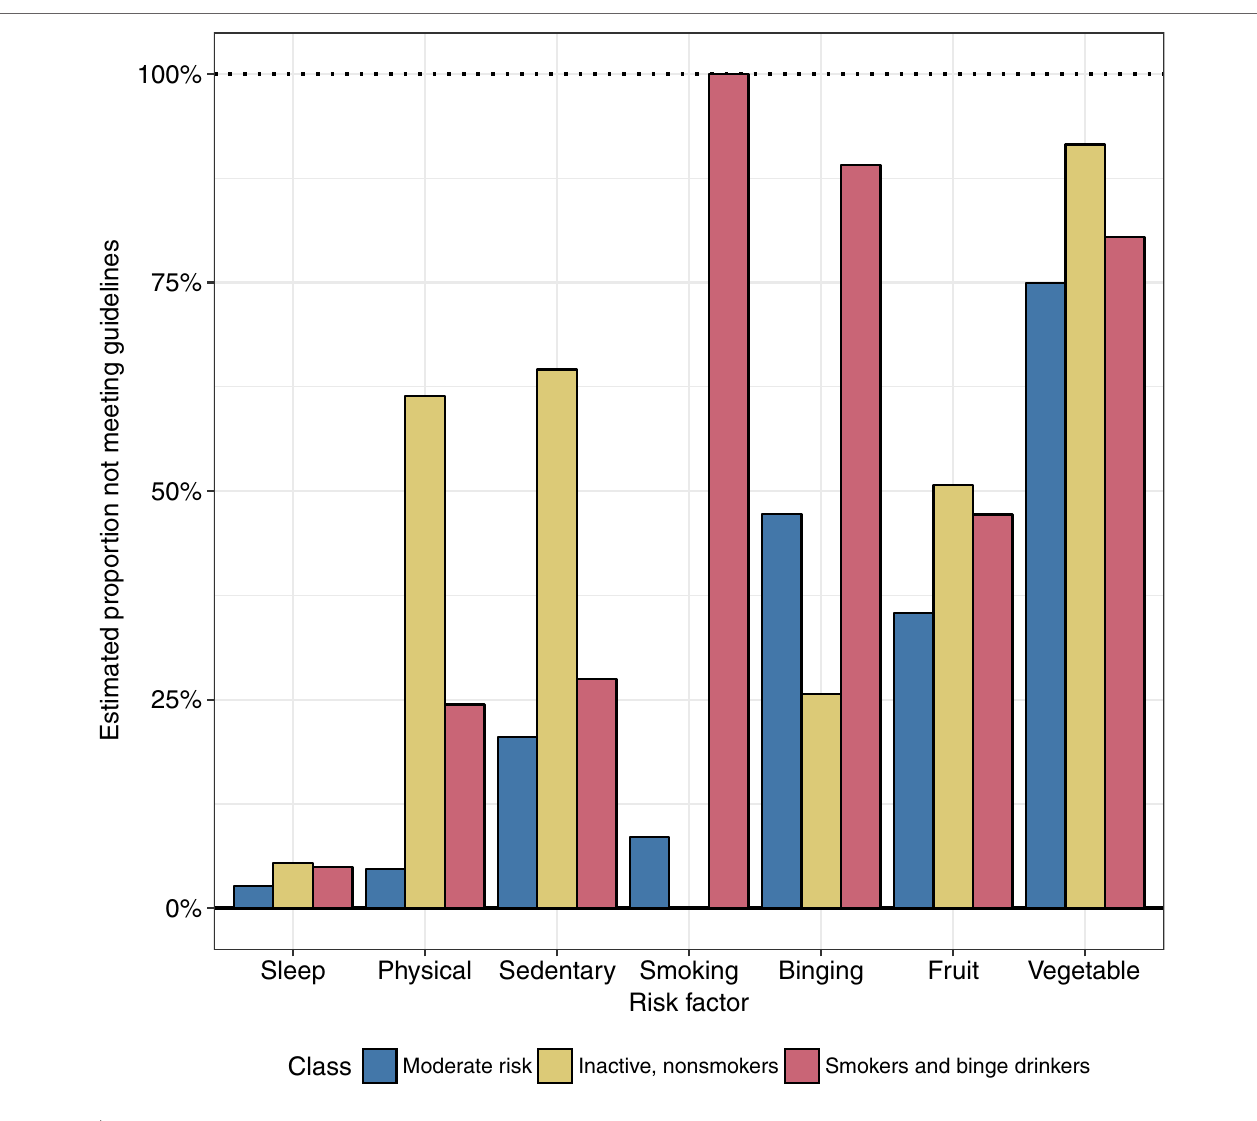
FigUre 1 | Estimated response probabilities of lifestyle risk behaviors in each latent